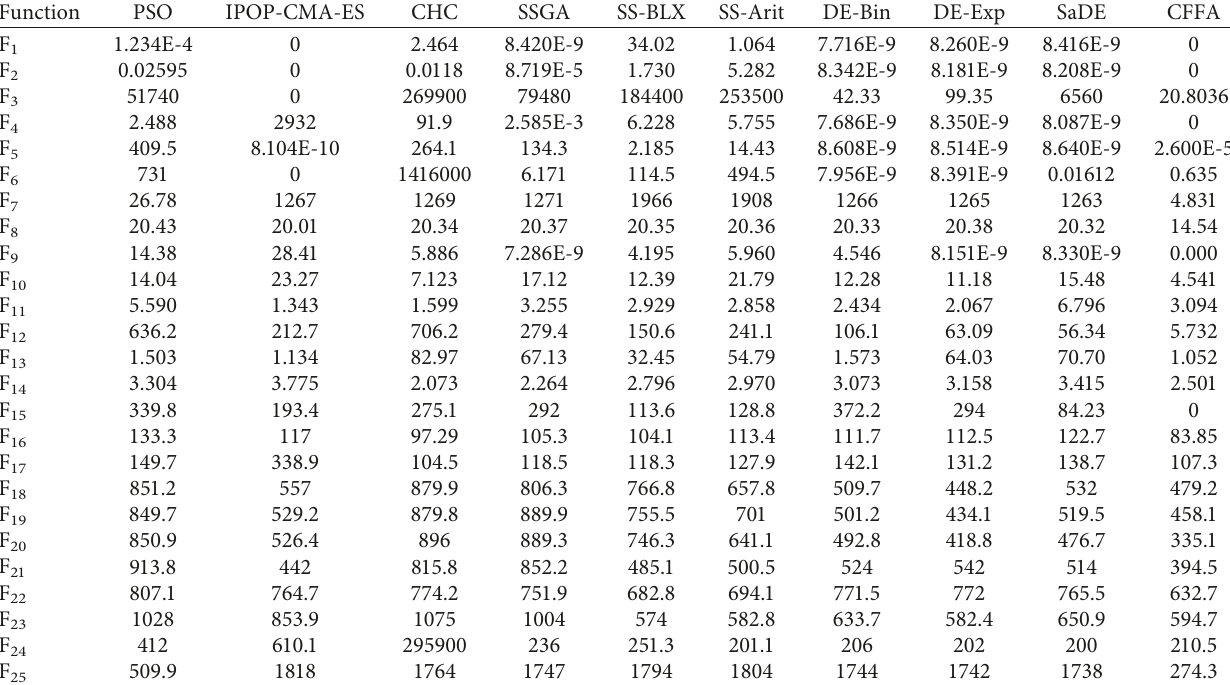
Table 3: The average error of the 25 CEC’2005 benchmark functions as determined by CFFA and comparing